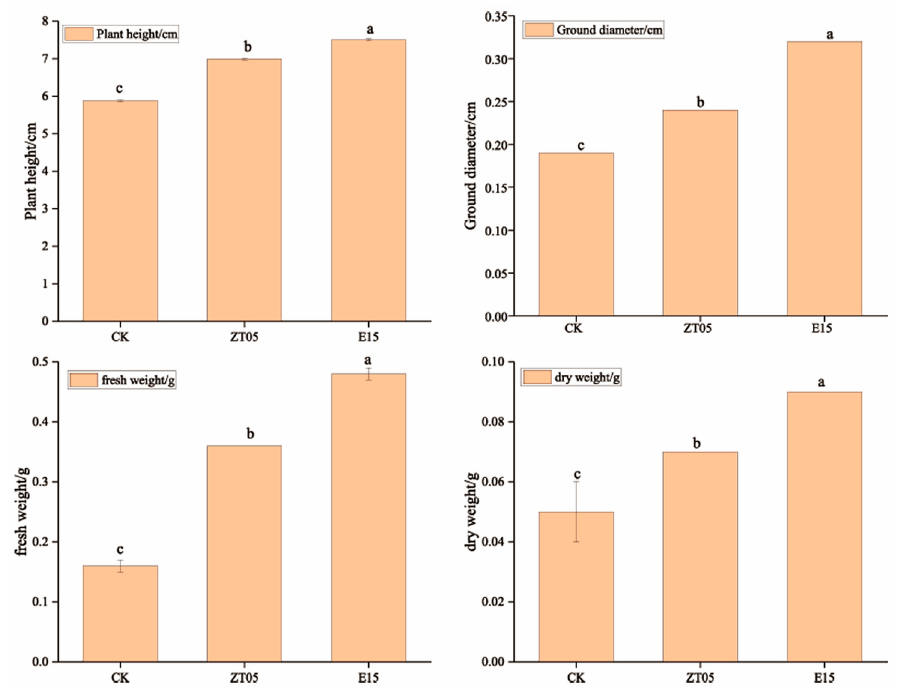
Figure 1. E ff ects of Trichoderma inoculation on plant growth. CK: inoculation with PD blank culture medium. ZT05: single inoculation with T. virens ZT05. E15: single inoculation with T. harzianum